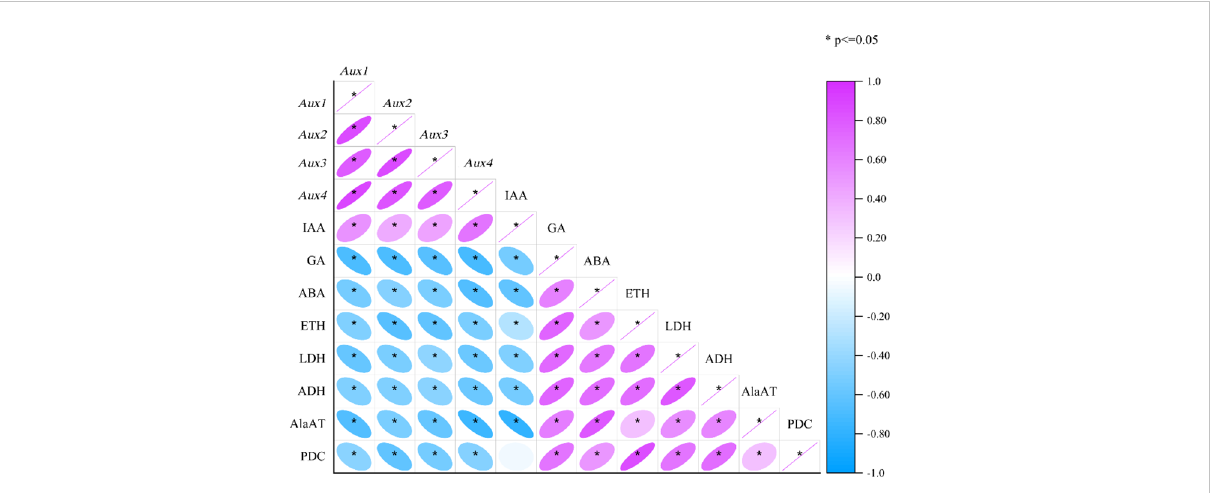
FIGURE 7 Correlation matrix of physiological and gene factors of the roots cultivated with and without mulching and aeration. PDC: pyruvate decarboxylase; AlaAT: alanine aminotransferase; LDH: lactate dehydrogenase; ADH: alcohol dehydrogenase; IAA: indole-3-acetic acid; ETH: ethylene; ABA: abscisic acid; GA: gibberellic acid and Aux1 , 2 , 3 , 4 : auxin-related genes 1, 2, 3 and 4, respectively.